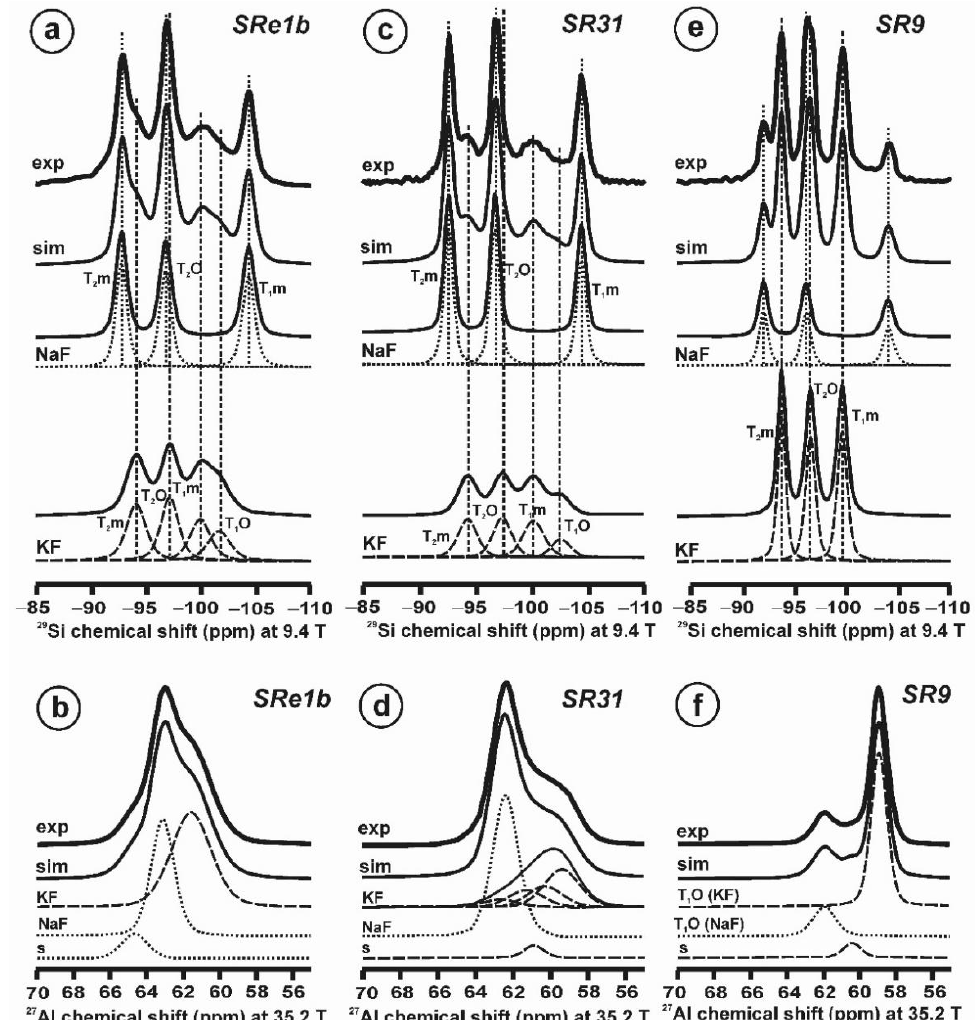
Figure 20. The NMR spectra of the three specimens of moonstone (NMR parameters in Table 9). ( a ) The 29 Si NMR spectrum of specimen SRe1b at 9.4 T has been simulated with two phases, one with three resonances from Na-feldspar corresponding to Si atoms in T 1 m, T 2 O and T 2 m sites, the other with four resonances for K-feldspars related to Si atoms in T 1 O, T 1 m, T 2 O and T 2 m sites. ( b ) The 27 Al NMR spectrum of specimen SRe1b at 35.2 T has been simulated with three resonances, one broad peak from the K-feldspar and two resonances from the Na-feldspar. ( c ) The 29 Si NMR spectrum of specimen SR31 at 9.4 T has been simulated with two phases as in ( a ). ( d ) The 27 Al NMR spectrum of specimen SR31 at 35.2 T can be deconvoluted by using a single resonance from the Na-feldspar, an asymmetric signal composed of four resonances like in orthoclase for the K-feldspar, and an additional resonance attributed to strain in the K-feldspar component. ( e ) The 29 Si NMR spectrum of specimen SR9 at 9.4 T has been simulated with the same two phases (Na- and K-feldspar), each one with three resonances for Si atoms in T 1 m, T 2 O and T 2 m sites. ( f ) The 27 Al NMR spectrum of specimen SR9 at 35.2 T has been deconvoluted into three resonances, two signals from K-feldspar, one from Al atoms at the T 1 O site and the other from structural strain, and one signal in Na-feldspar from Al atoms at the T 1 O site. All the resonances were simulated with Voigt curves at xG/(1 − x)L = 0.7. Dotted lines show the components of the Na-feldspar phase, and dashed lines show those of the K-feldspar phase; s are the resonances from structural strain; exp are used for the experimental spectra, and sim for the simulated spectra. Experimental procedure for the 27 Al spectra at 35.2 T as in Figure 1; for the 29 Si spectra as in ref [4].